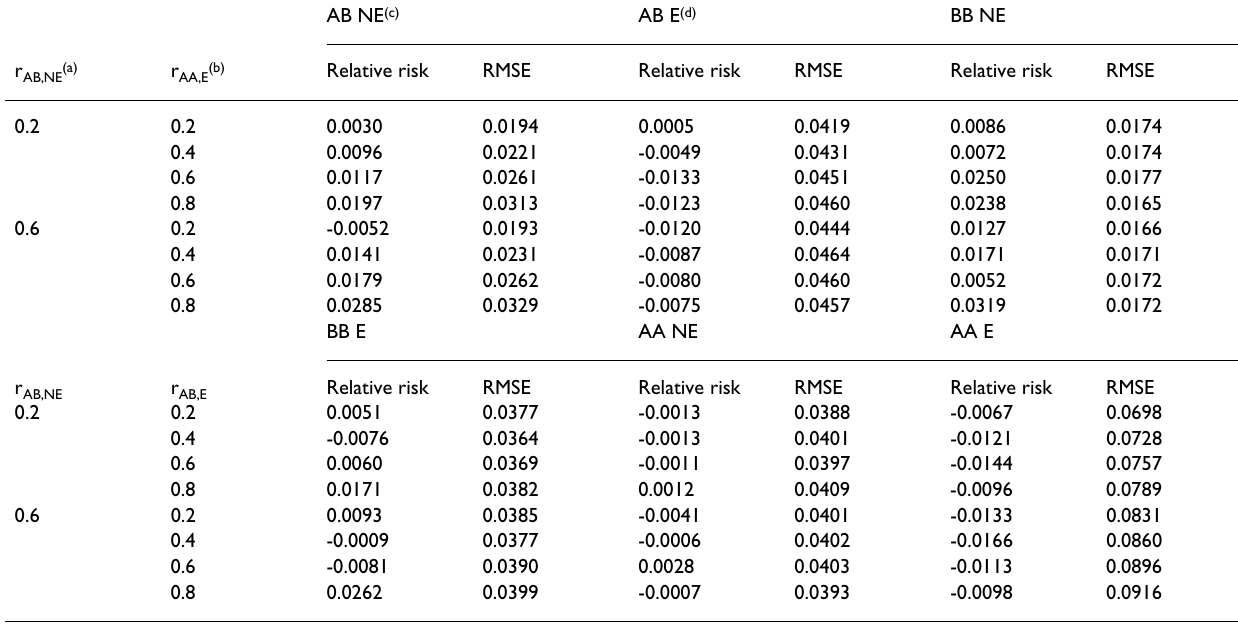
Table 6: Relative bias and RMSE of the disease risks predicted using the full model in the third